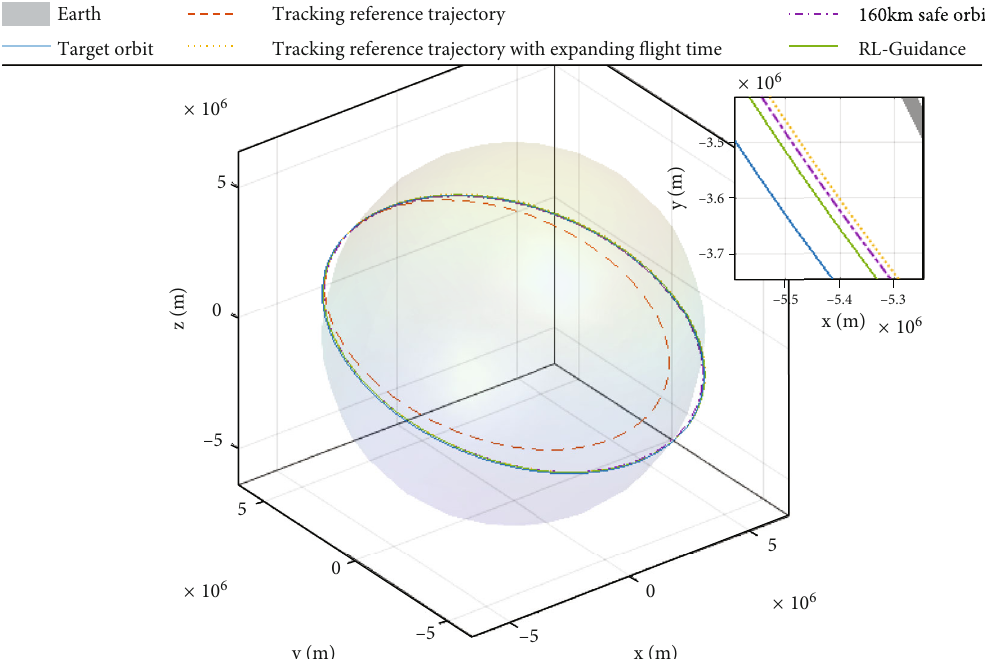
Figure 13: Orbit reached by using di ff erent guidance in experiment